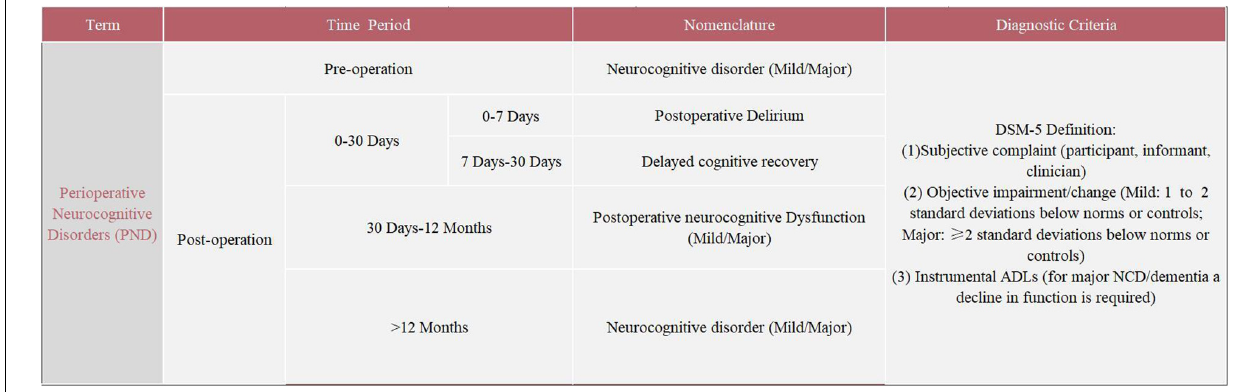
FIGURE 1 | Nomenclature of perioperative neurocognitive disorders